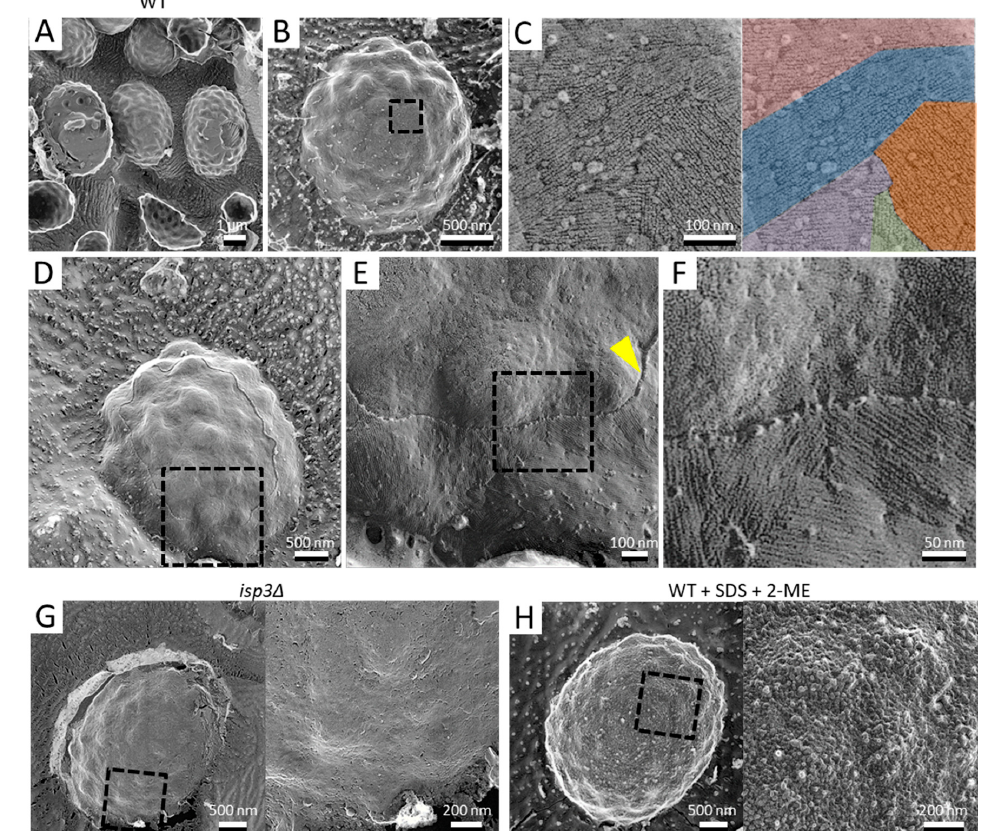
Figure 1. Surface structure of the S. pombe spore. ( A ) Field image of wild-type spores. Left spore shows a cytoplasmic cross-section. Center spore shows partial detachment of the surface layer. Right spore shows partial detachment of the spore wall. ( B ) Single spore. ( C ) Left, Magnified image of the boxed region in B. Right, the fibrillar structures are shown in various colors. ( D ) Spore with the outermost layer partly removed by fracture. ( E ) Magnified image of the boxed region in D. Arrowhead indicates a cross-section of the fractured surface layer. ( F ) Magnified image of the boxed region in E. ( G ) Left, isp3 Δ spore. Right, magnified image of the boxed region. ( H ) Left, wild-type spore pretreated with 1% SDS and 5% β -mercaptoethanol (2-ME). Right, magnified image of the boxed region.